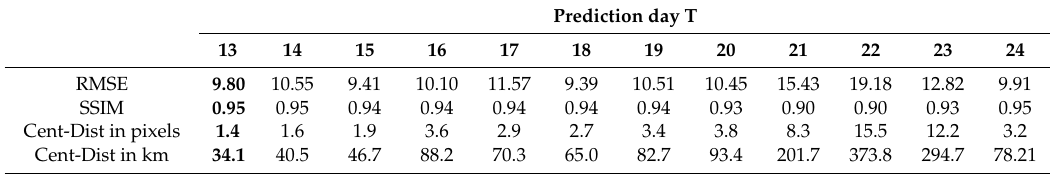
Table 16. Daily comparison of RMSE, SSIM, and centroid distance of case 10.